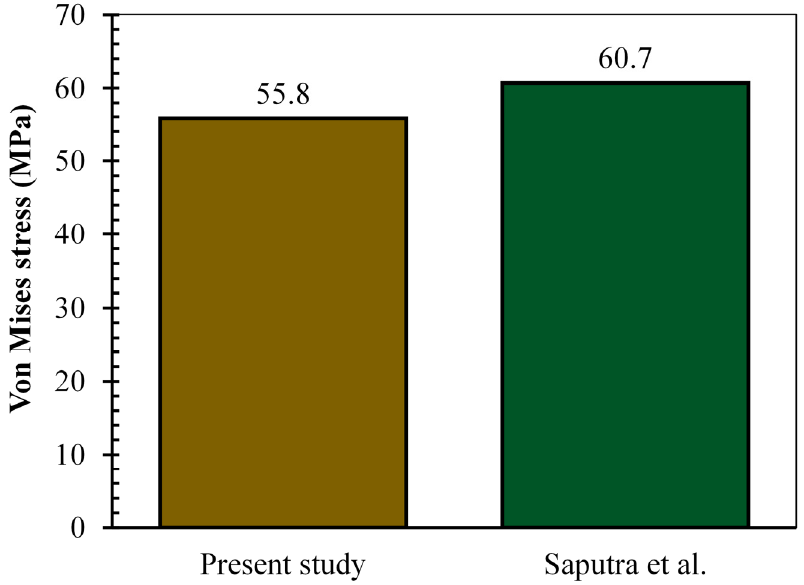
Figure 5. Present von Mises stress result validation of CoCrMo-on-CoCrMo bearing of total hip prosthesis with similar previous von Mises stress investigation performed by Saputra et al. [24].